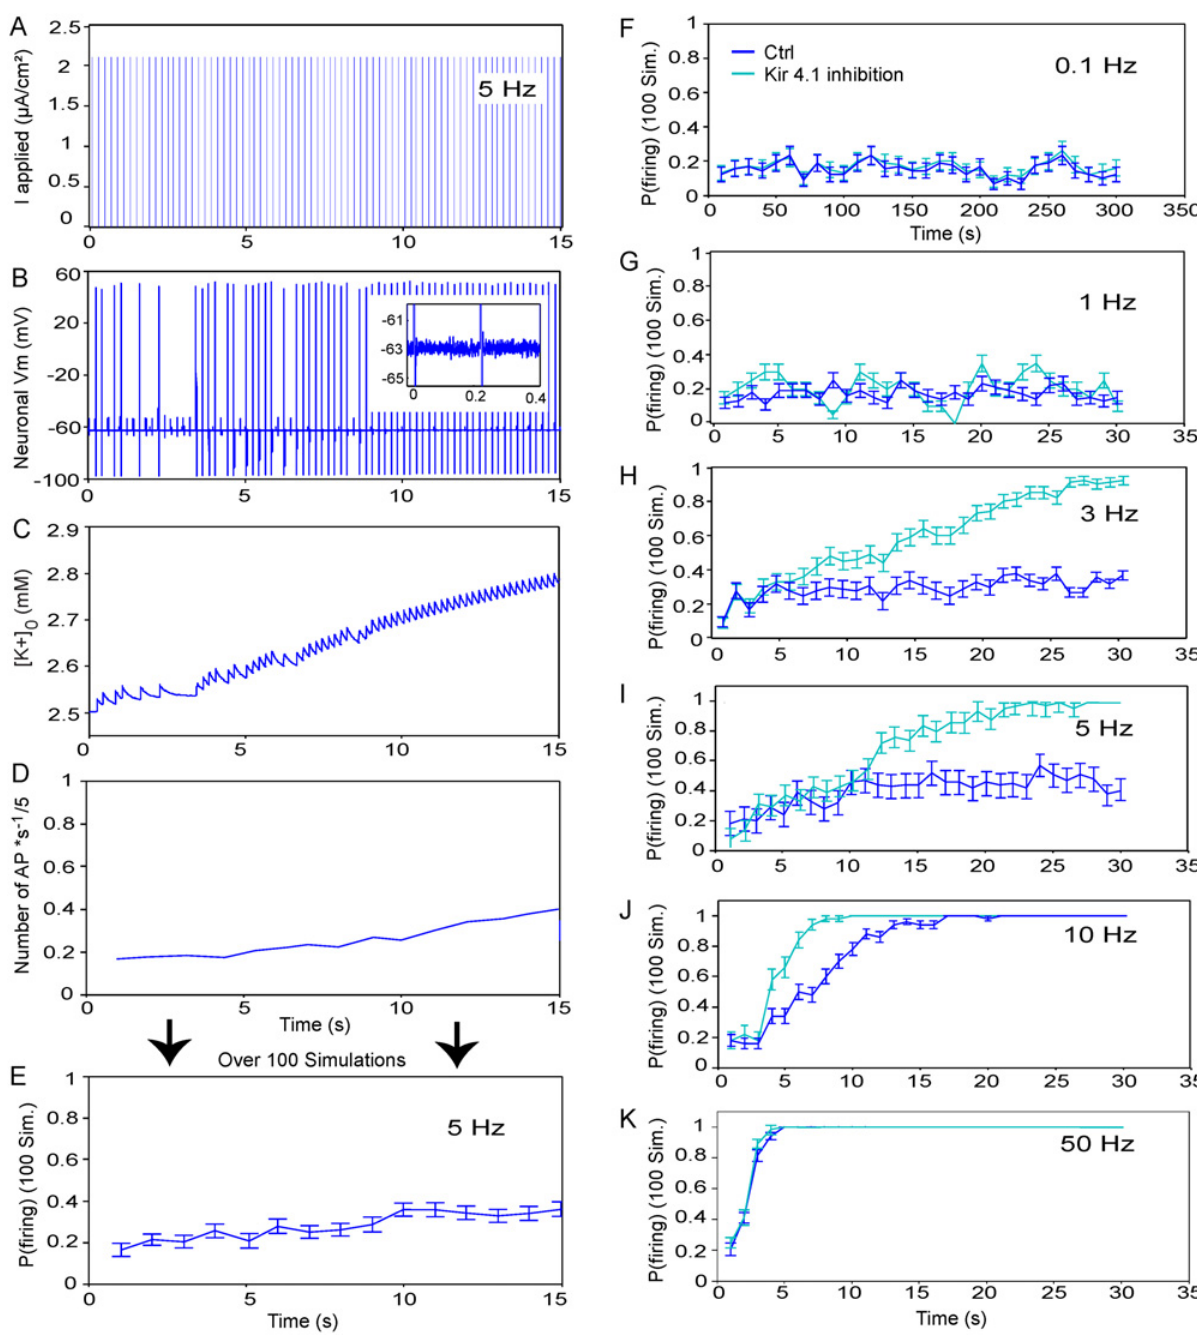
Fig 5. Involvement of K ir 4.1 channels in firing probability induced by Brownian noise and sub-firing stimulation. A-E , To induce probabilistic firing, a periodic sub-firing 5 Hz stimulation (5 ms squared stimulus) was set as the input of our tri-compartment model ( A ). Moreover, a Brownian source of amplitude σ = 0.68 pA 2 . ms -1 was added to induce a neuronal membrane potential noise of 1 mV amplitude (Inset in B ). Corresponding neuronal firing ( B ), [K + ] estimated firing probability (number of action potentials (AP) per second/stimulation frequency) obtained by one simulation ( D ) are illustrated below for a 5 Hz stimulation during 15 seconds. E , Quantification of the average firing probability computed over 100 numerical simulations for 5 Hz stimulation during 15 seconds in control condition. F-K , Same quantification over time as in ( E ) in control (Ctrl, blue) and inhibited K ir 4.1 channel (light blue) conditions illustrated for 0.1 Hz ( F ), 1 Hz ( G ), 3 Hz ( H ), 5 Hz ( I ), 10 Hz ( J ) and 50 Hz ( K )